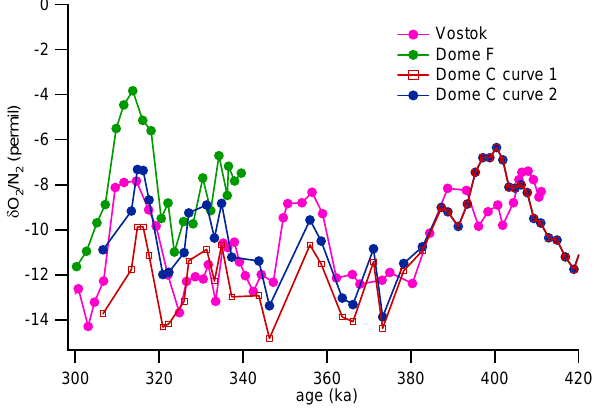
Fig. 3. Comparison between the two composite EDC δ O 2 /N 2 curves and existing δ O 2 /N 2 records from Dome F (Kawamura